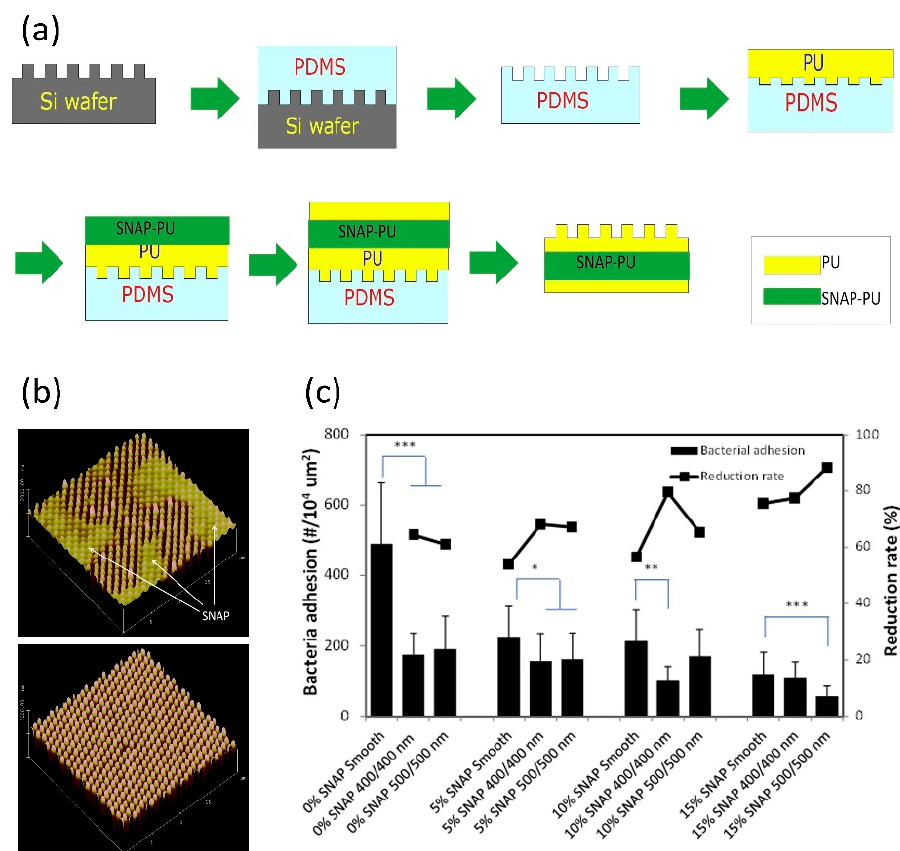
Figure 11. ( a ) The preparation of SNAP-doped textured PU surface using soft lithography two-stage replication molding technique. ( b ) 3D atomic force microscope (AFM) images of NO releasing textured polyurethane film surface, in which thin top layer showing the di ff usion of SNAP onto top surface (above), and thick top layer showing normal textured surface feature (below). ( c ) Bacterial adhesion and reduction rates (against smooth regular PU polymer) on NO releasing textured polyurethane surfaces, in which asterisks represent a statistically significant di ff erence in bacterial adhesion relative to non-textured surface, with * denotin p < 0.05, ** denoting p < 0.01, and *** denoting p < 0.001. Reproduced with permission from [157]. Copyright 2017, Elsevier.